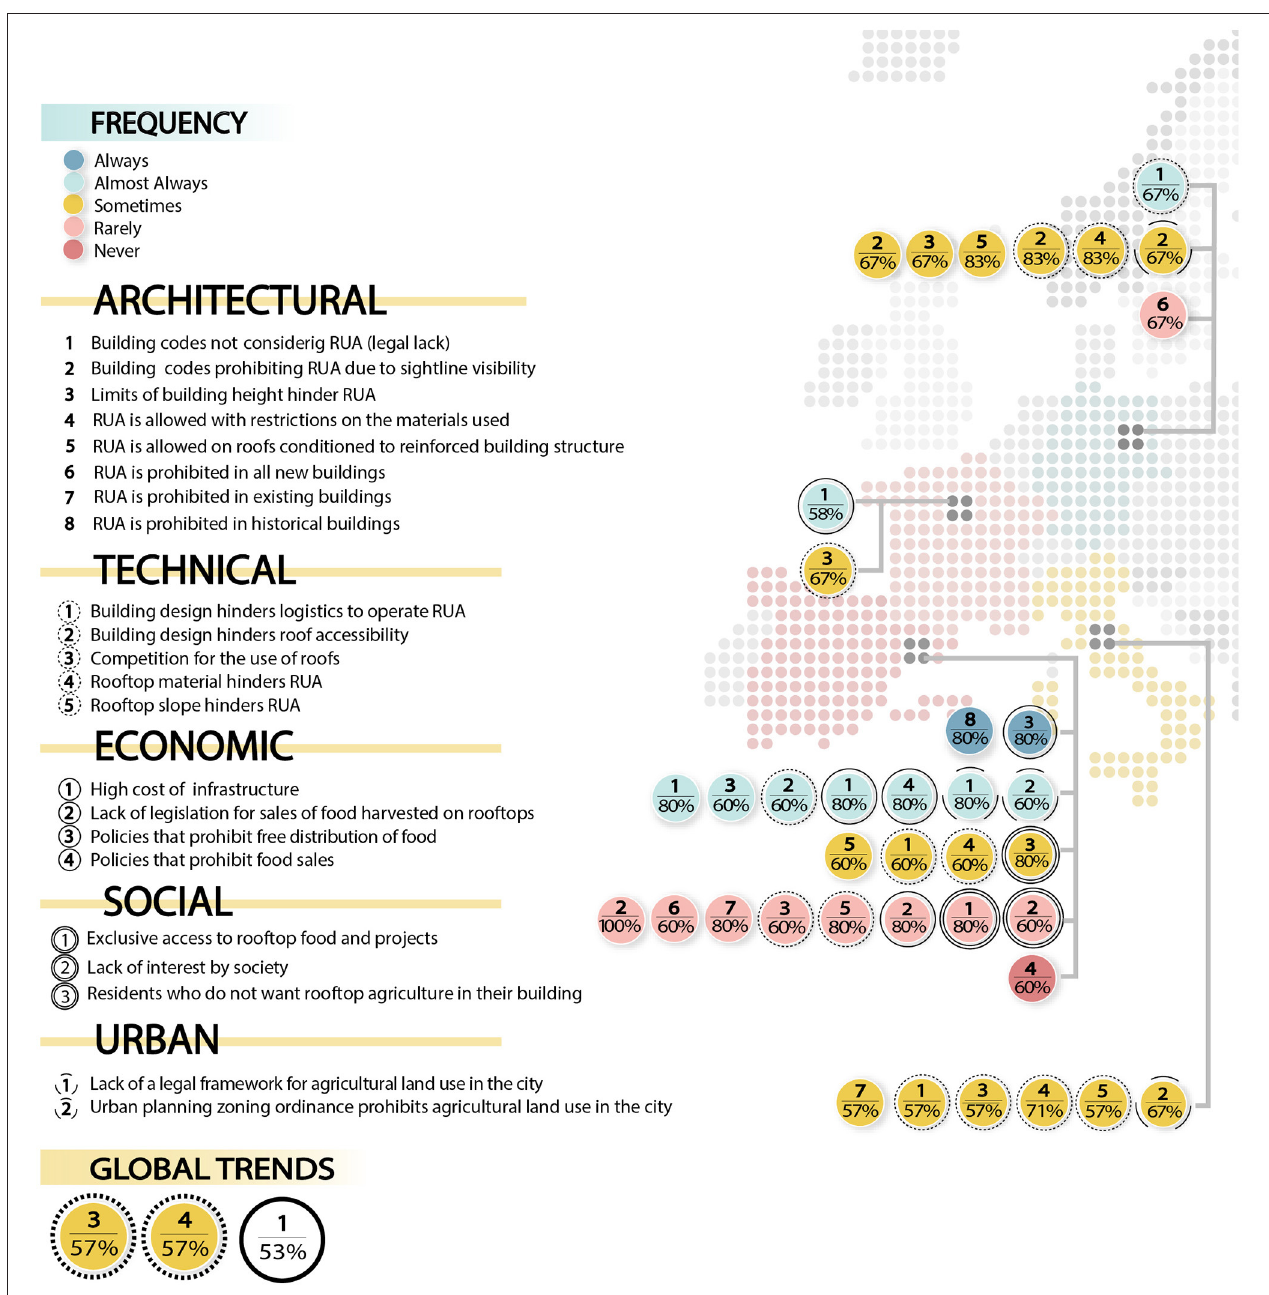
FIGURE 7 | Barriers and perceived frequency with which they appear for integrating RUA in four European